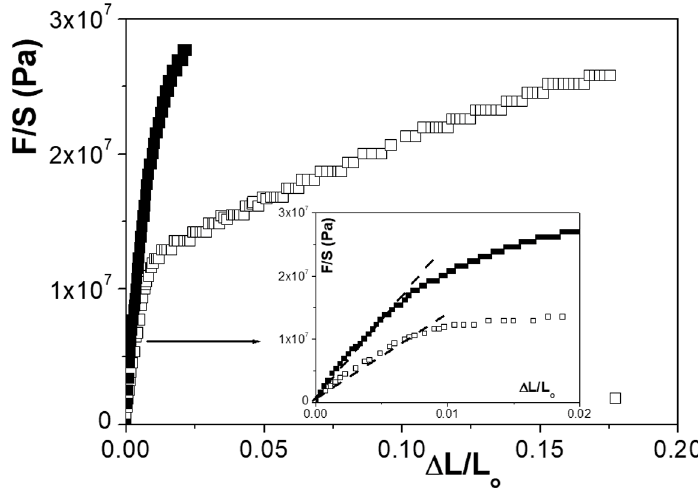
Figure 1. Strain-stress vs. elongation curves for wet ( □ ) and dry ( ■ ) samples of the 26% AlqCl/74% CTA PIM.